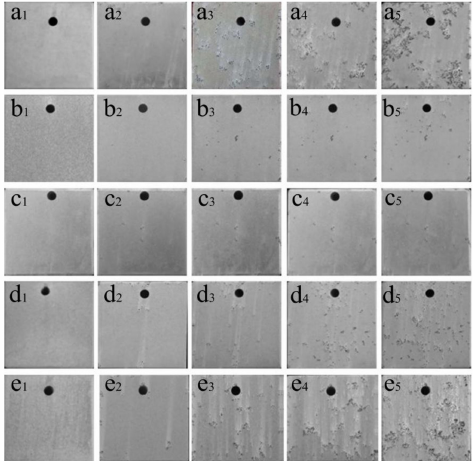
Figure 11. Optical corrosion morphologies of the LDHs coatings at different formation times